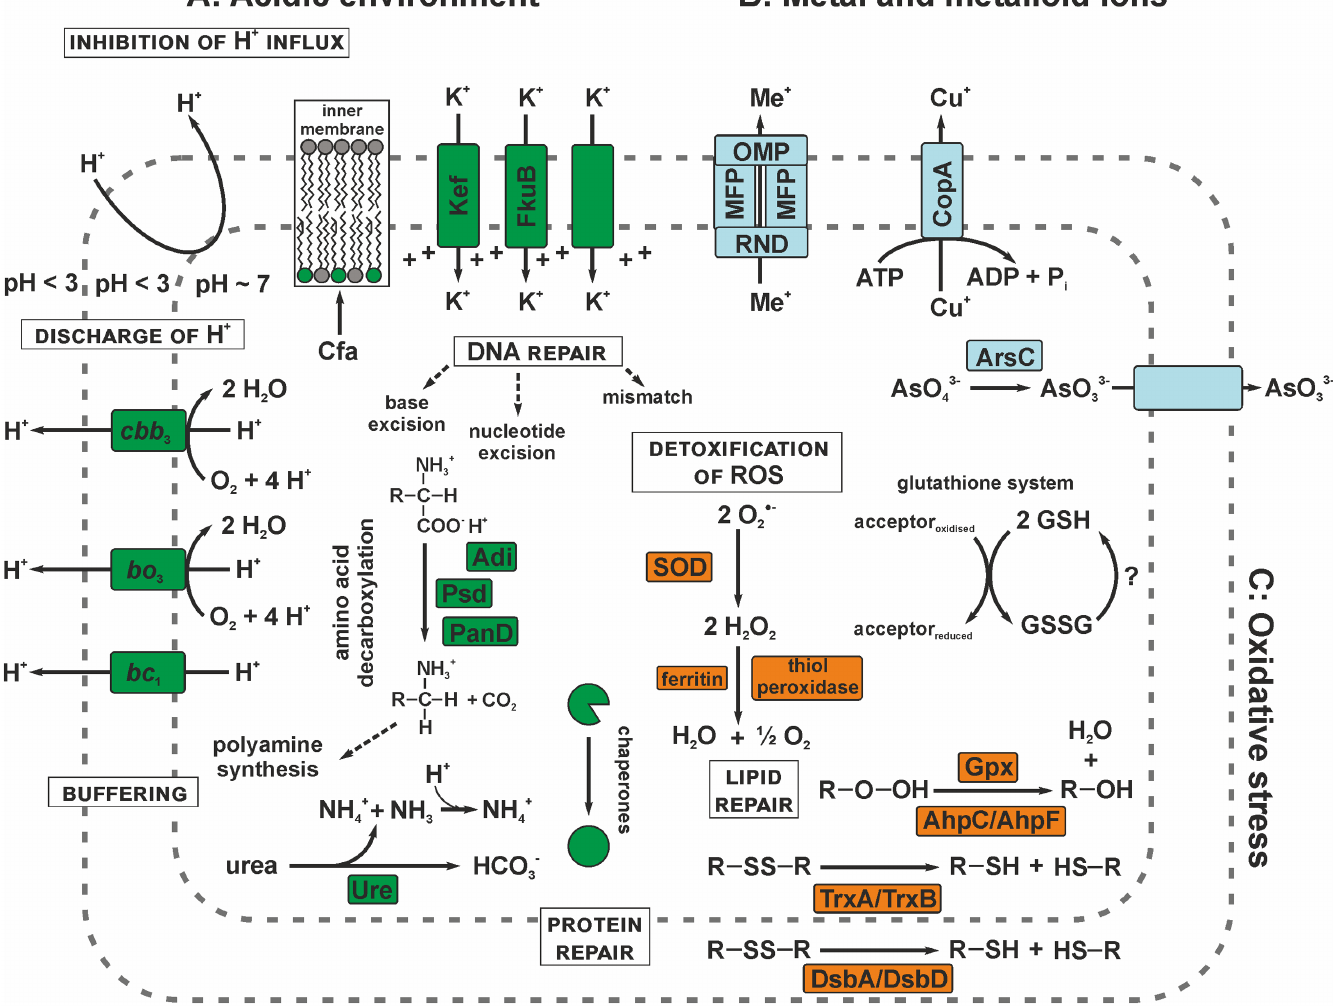
Fig 5. Predicted stress management strategies in “ Ferrovum ” strain JA12. “ Ferrovum ” strain JA12 appears to employ strategies acting at different levels to maintain the intracellular pH homeostasis (A, green). Uncontrolled proton influx could be inhibited by incorporating cyclopropane fatty acyl phospholipids (Cfa) in the membrane or by building up an inside positive membrane potential by the increased uptake of K + -ions (Kef, FkuB). Apparently, the complexes of the respiratory chain ( bc 1 , bo 3 , cbb 3 ) contribute to the active discharge of protons. Furthermore, “ Ferrovum ” strain JA12 is predicted to buffer protons by the decarboxylation of arginine (Adi), phosphatidylserine (Psd) or aspartate (PanD) and by the hydrolysis of urea via the urease (Ure). Damaged proteins appear to be restored by a number of chaperones. “ Ferrovum ” strain JA12 could cope with the high concentrations of metal and metalloid ions (B, light blue) either using specific systems like the copper efflux pump (CopA) or arsenate reductase (ArsC) and the arsenite efflux pump. Alternatively, more general multidrug transport systems of the RND family involving an efflux pump (RND), membrane fusions proteins (MFP) and an outer membrane protein (OMP) could be used to extrude metal ions. Oxidative stress (C, orange) is apparently managed by the detoxification of reactive oxygen species (ROS) using a superoxide dismutase (SOD) or thiol peroxidases and ferritin. Damaged proteins could be repaired in the cytoplasm using a thioredoxin (TrxA)/ thioredoxin reductase (TrxB)-dependent system or via the thiol:disulfide interchange proteins (DsbA, DsbD) in the periplasm. Damaged lipids may be restored by the peroxiredoxin (AhpC)/ alkyl hydroperoxide reductase (AhpF)-dependent system or by the glutathione peroxidase (Gpx). “ Ferrovum ” strain JA12 could use glutathione (GSH)-dependent systems to restore the redox balance, though it remains unclear how glutathione disulfide (GSSG) is recycled. A wide repertoire of DNA repair systems is predicted serve in the repair of damaged DNA (see also S3F Table).